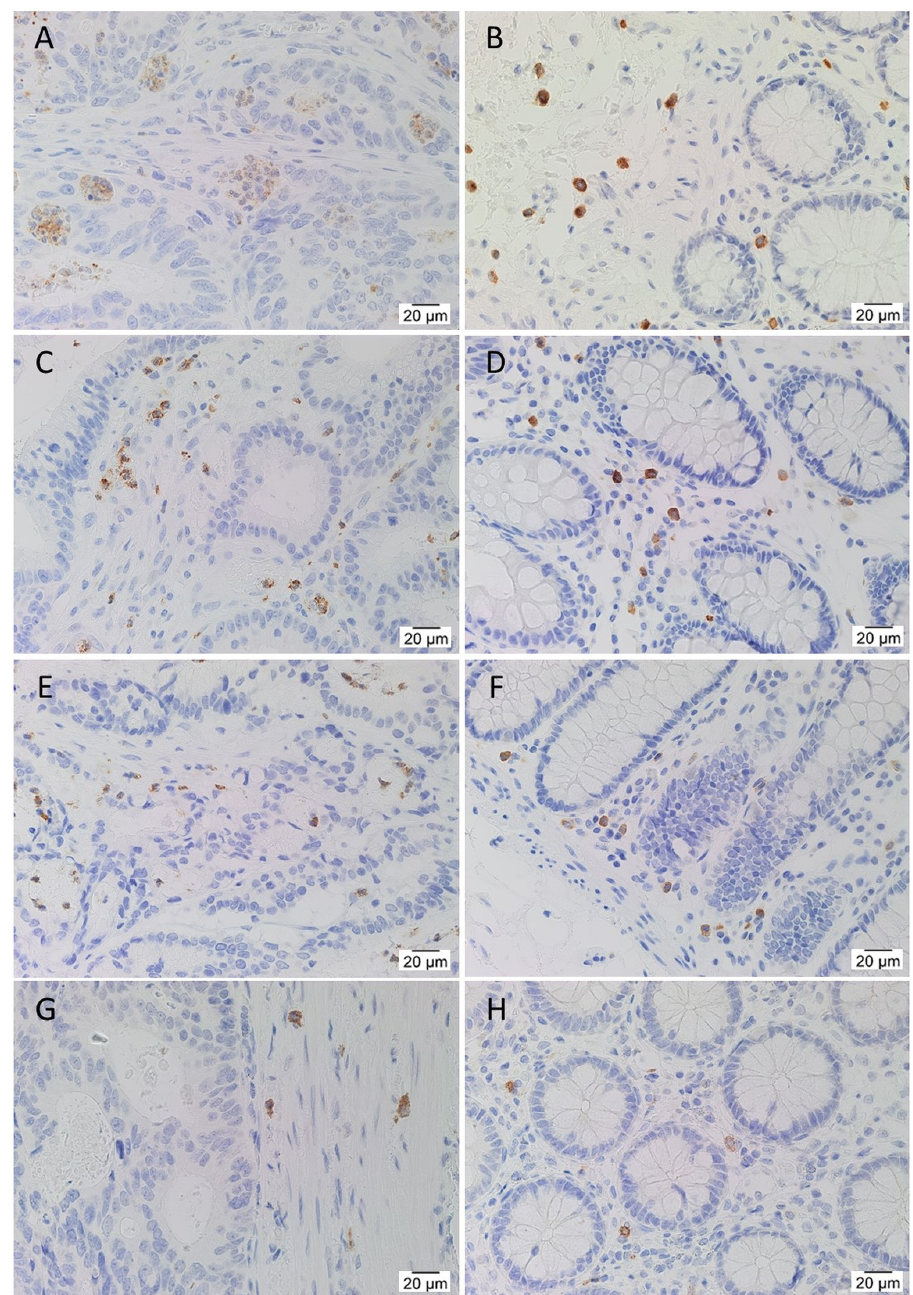
Fig 6. IHC staining for cathepsin G. Representative IHC stained images of CTSG (brown), including 2 LGCA samples (A, C) and their patient-match NC tissues (B, D), and 2 HGCA samples (E, G) and their patient-matched NC tissues (F, H). Nuclei were counterstained with hematoxylin (A-H, blue); original magnification: 400x. Reproduced from [38] under a CC BY license, with permission from Munro MJ et al . 2021. produced almost identical results. The R- and S-enantiomers of propranolol were adminis- tered separately and as a racemic mixture, and a 50 μ M dose of either enantiomer alone or of the racemic combination caused > 90% inhibition of metabolic activity by 48 h in all 4 cell lines. Doses of 10 μ M and 1 μ M did not make a significant difference at any time point.